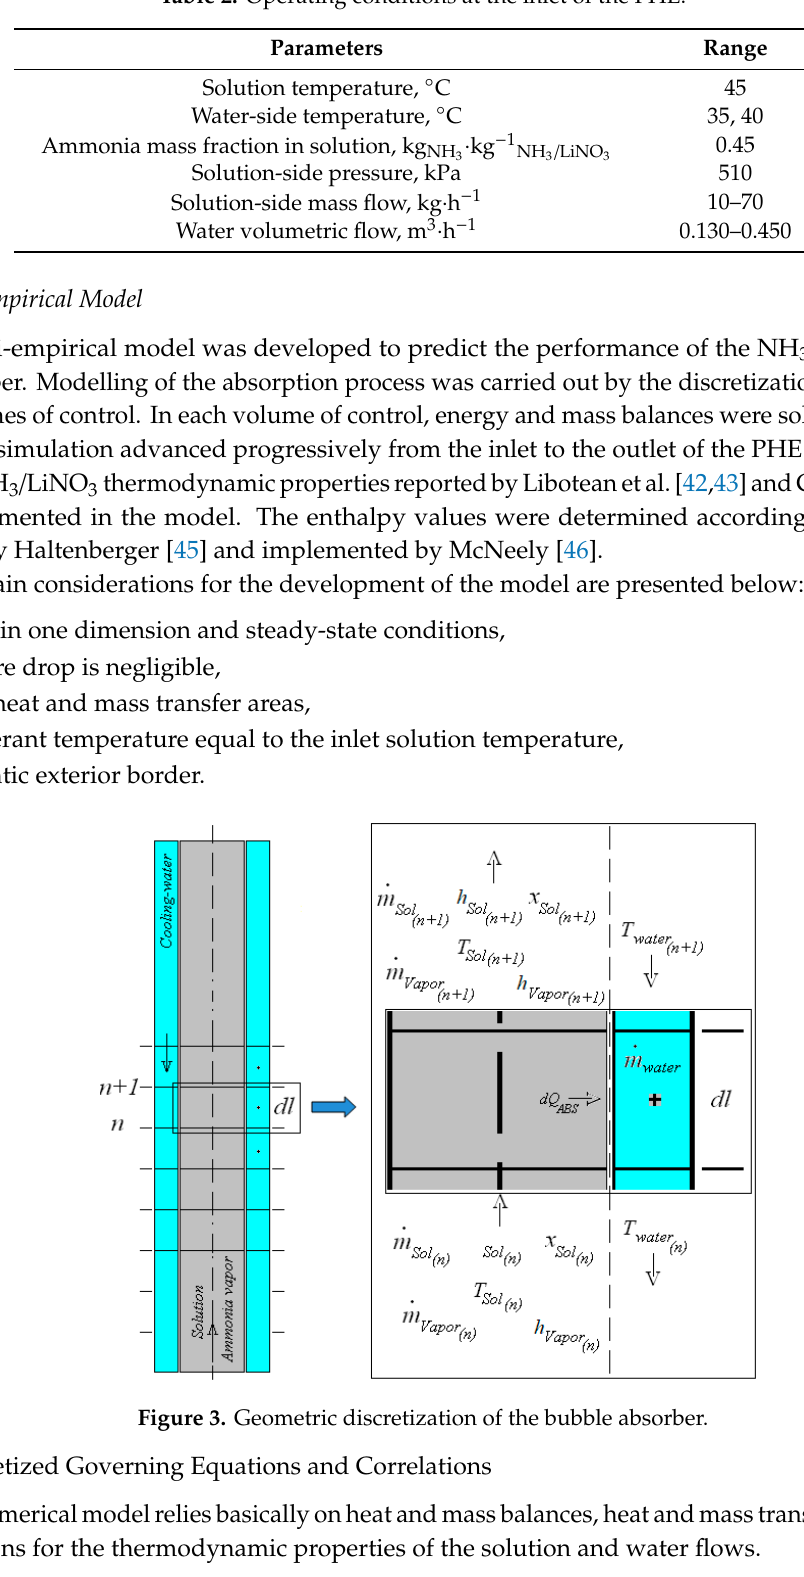
Table 2. Operating conditions at the inlet of the PHE.